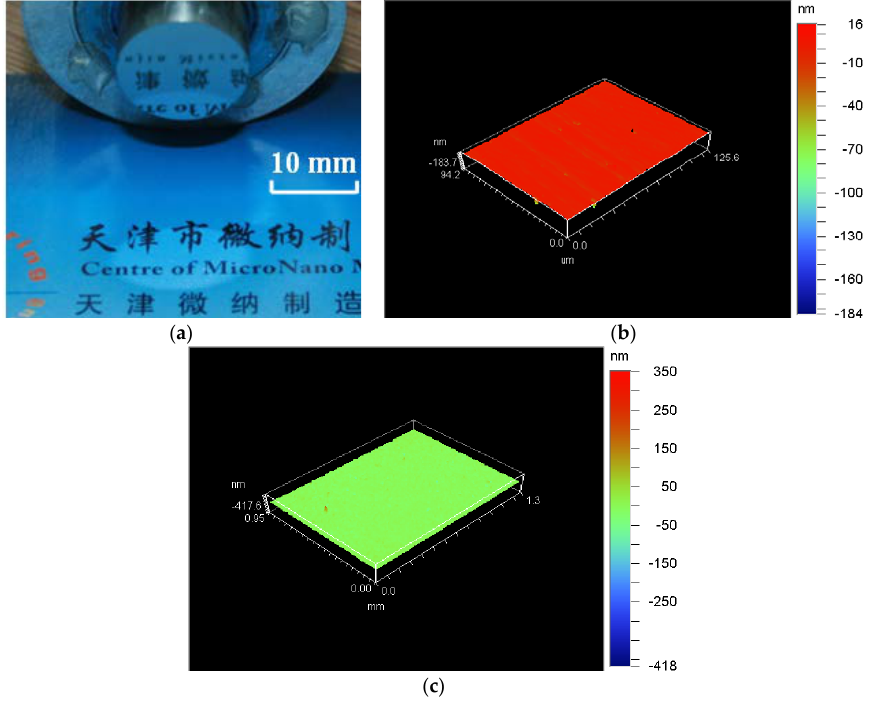
Figure 16. Surface topography of the machined workpiece using the proposed method; ( a )Photo of the machined workpiece; ( b ) Ra 1.82 nm when diamond tool cutting in a very short distance; ( c ) Ra 6.2 nm when diamond tool cutting near the center of